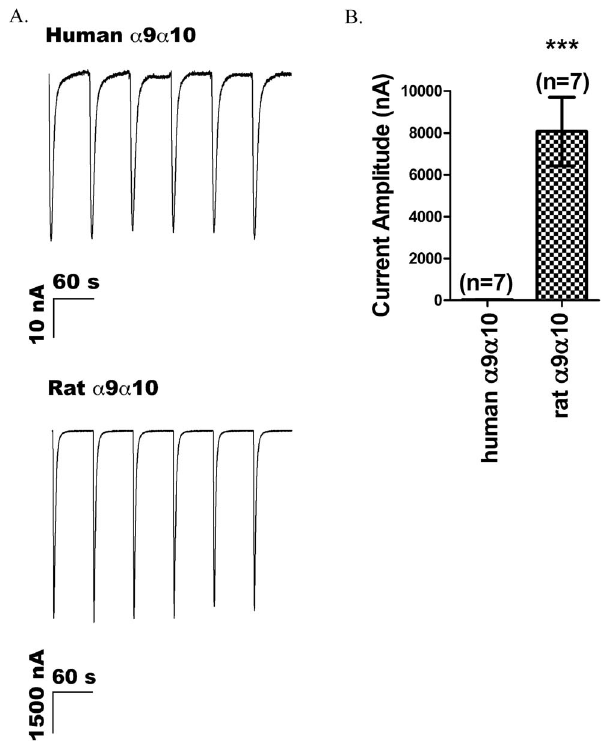
Figure 1. Comparison between the levels of exogenous expression of rat and human a 9-containing nAChRs in X.laevis oocytes. ACh-gated currents were measured in voltage-clamped oocytes as described in Methods. (A) Representative traces from an oocyte injected with human a 9 and human a 10 cRNA (top) and rat a 9 and rat a 10 cRNA (bottom). Robust currents were observed with rat cRNA; but only small currents were observed with human cRNA. (B) Comparison of the averaged current responses evoked by 100 m M ACh applications from oocytes expressing human a 9 a 10 and rat a 9 a 10 receptors. The mean current amplitude was 30 6 3 nA (n=7 oocytes) for human a 9 a 10 and 8067 6 1638 nA (n=7) for rat a 9 a 10, p , 0.005. Error bars indicate